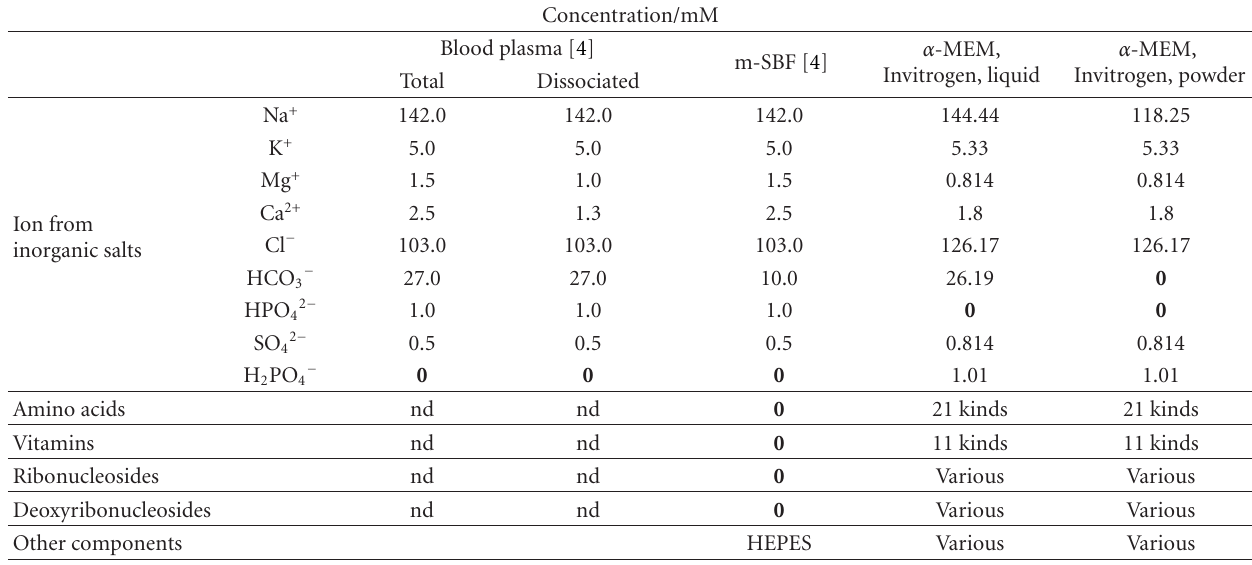
Figure 3: Typical SEM pictures of the coatings. (a) The picture before cell culture. Scale bar = 1 μ m. (b) The picture after cell culture and detaching the cells from the sample. Scale bar = 10 μ m. The red arrow indicated the remaining coating while the blue arrow indicated newly appeared layers or depositions. Table 1: The concentration of components in di ff erent